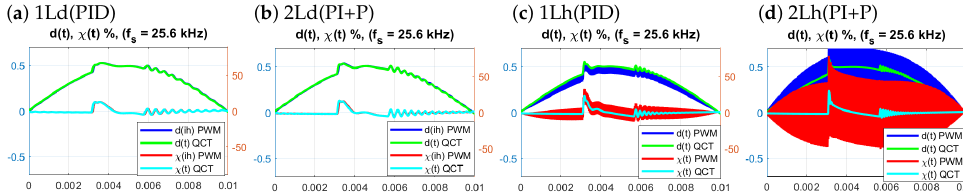
Figure 17. Functions d ( t ) and χ ( t ) and their sampled values in optimally tuned control systems ordered in ( a – d ) as in Figure 16 at f s = 25.6 kHz under a rectifier load. Note that the blurry shape of the continuous-time controller output d ( t ) is due to large intersample deviations from the values at sampling instants d ( ih ) depicted in light blue.